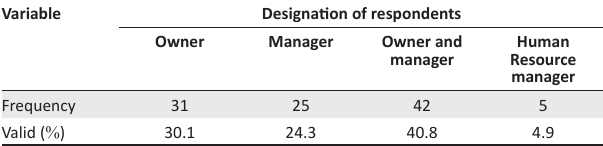
TABLE 3 : Designation of respondents.